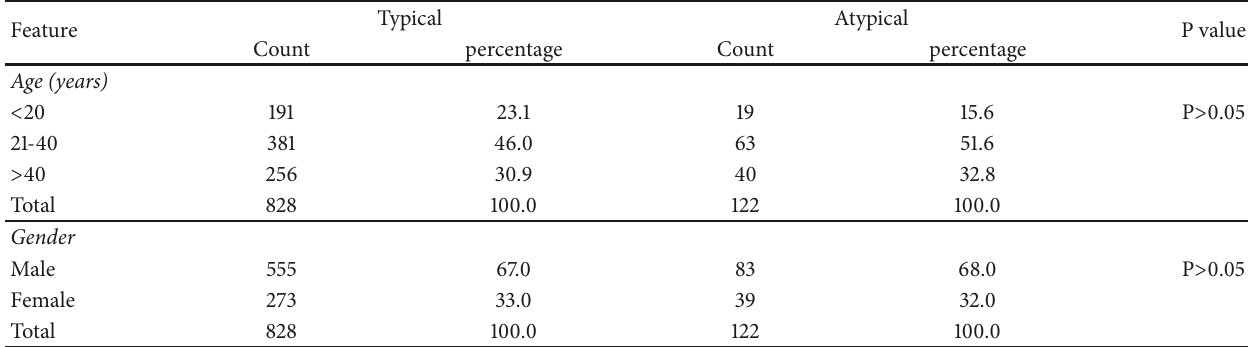
Figure 1: Typical developmental stages of a leishmanial skin lesion observed in the study population. (a) papular lesion on the face, (b) enlarging nodular lesion on the face, (c) early ulcerating nodule on the forearm, and (d) completed ulcer on the forearm. Table 1: Sociodemographic features associated with atypical